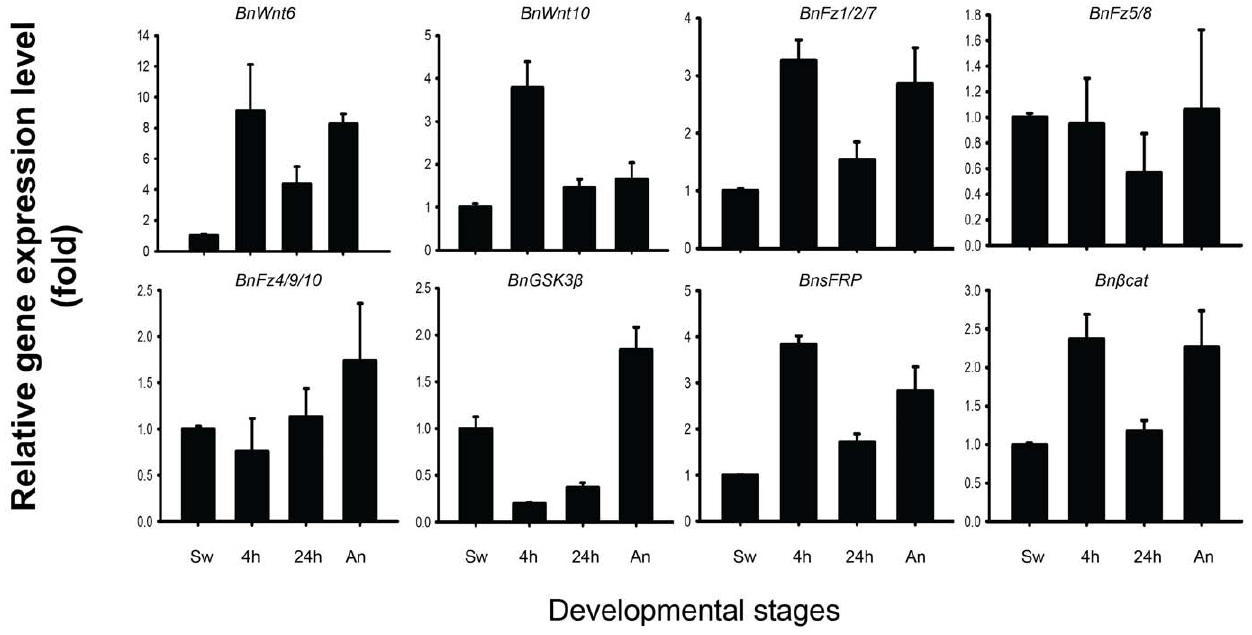
Figure 2. Temporal gene expression pattern of Wnt s, Frizzled receptors, b cat enin, GSK3 b , and sFRP across metamorphosis of B. neritina . Gene expression levels at the swimming larval stage was taken as the baseline in every analysis.